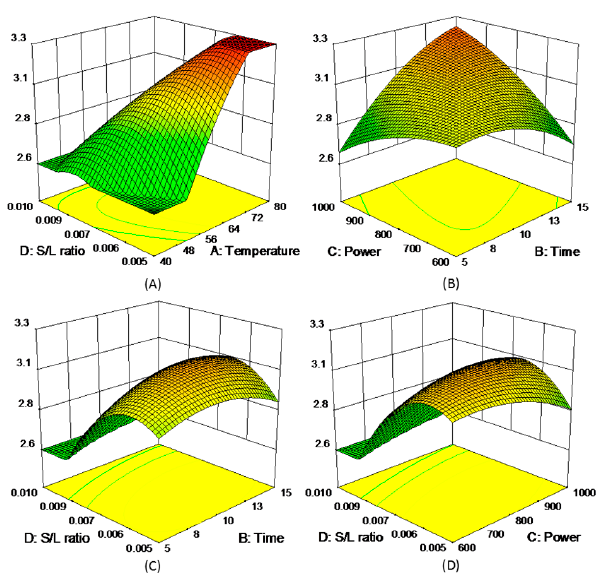
Figure 4. 3D response surface plots of LIT.